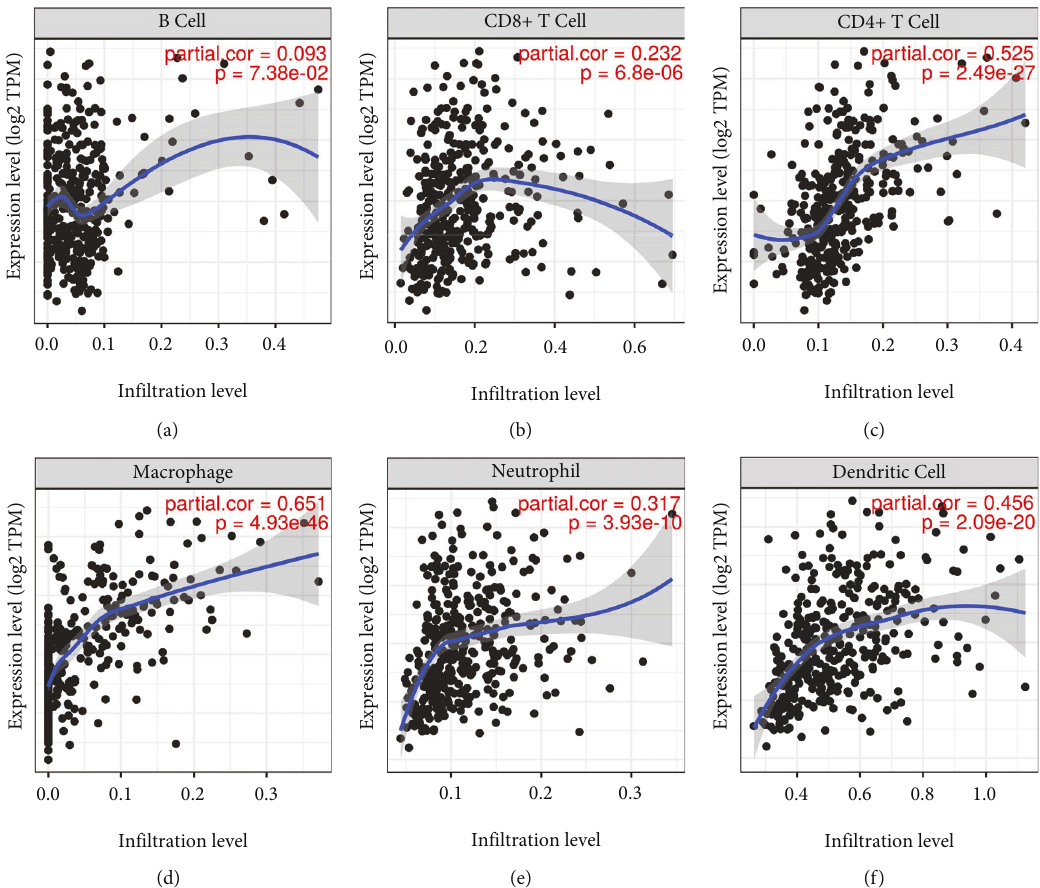
Figure 3: ZNF521 expression is correlated with the level of immune in fi ltration in STAD. (a) The expression of ZNF521 has no signi fi cant correlations with B Cells. (b) – (f) The expression of ZNF521 has positive correlations with in fi ltrating levels of CD8+ T cells, CD4+ T cells, macrophages, neutrophils, and dendritic